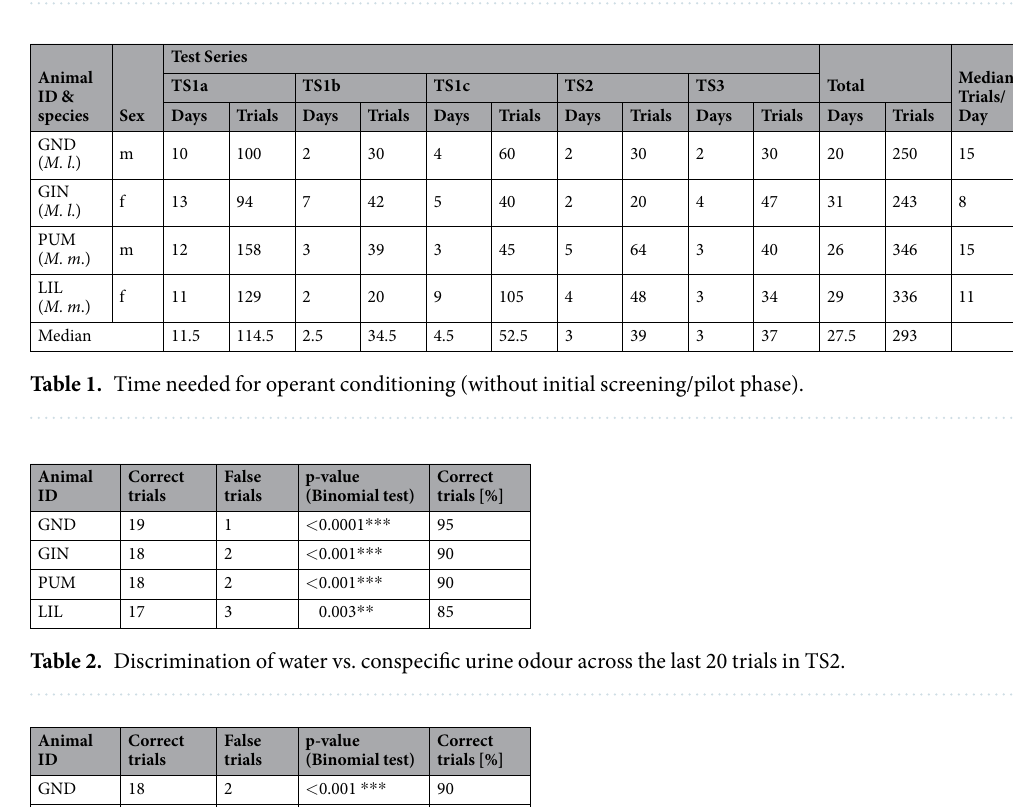
Figure 1. Number of suitable versus excluded test animals in pilot phase and screening. Animals that fulfilled all screening criteria are marked as “passed screening”, animals that were excluded during TS1a are marked as “failed screening” and animals that could not be habituated are marked as “not habituated”.